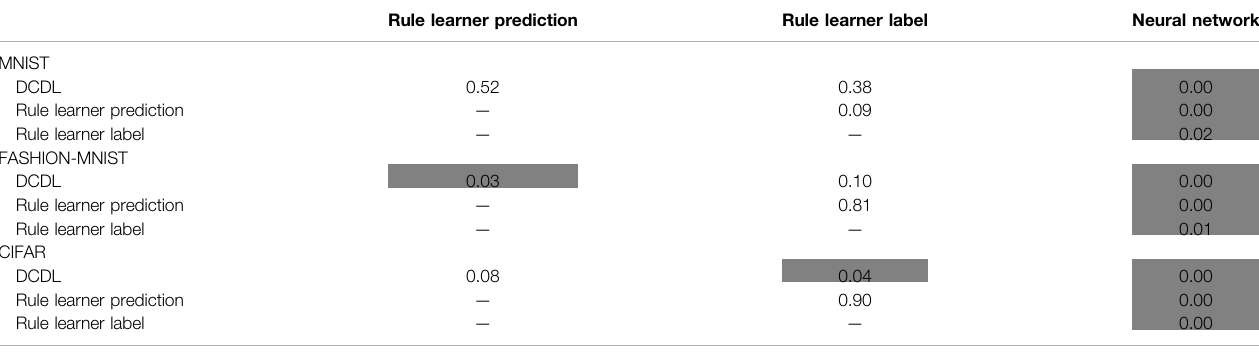
TABLE 2 | Shown are p -values of the corrected resampled t -test (Nadeau and Bengio, 2003) for MNIST, FASHION-MNIST and CIFAR with SLS normal labels for the accuracyvaluesplottedin Figure5 .Gray-shadedarethepairsforwhichthenullhypothesisisrejectedwithsigni fi cancelevel α (cid:2) 0 . 05usingacorrectedresampled t -test (Nadeau and Bengio, 2003).